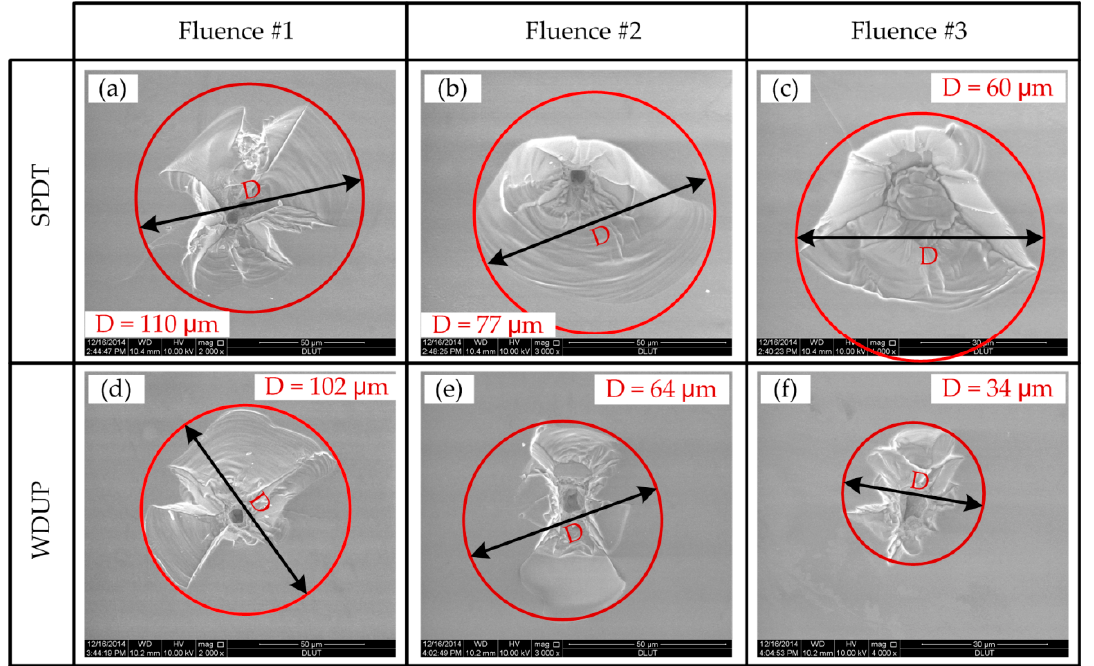
Figure 11. Damage morphologies of SPDT and WDUP machined crystal surface (Fluence#1 > Fluence#2 > Fluence#3).